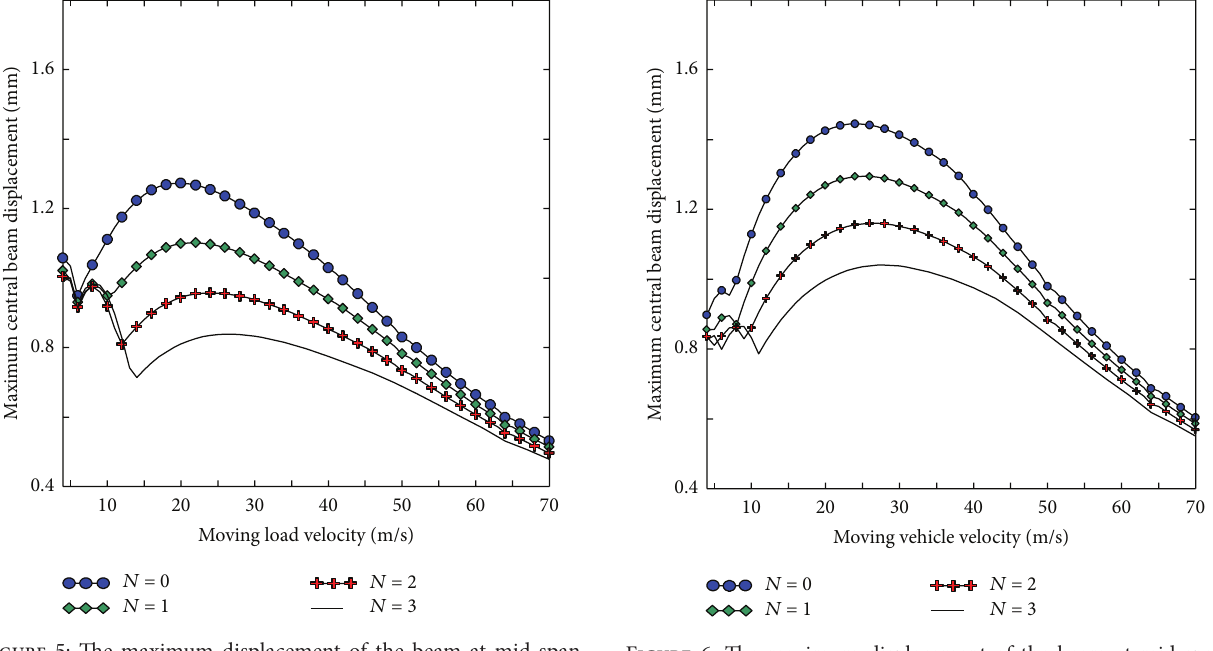
Figure 6: The maximum displacement of the beam at mid-span versus the velocity of the moving vehicle for 𝜁 = 0 .